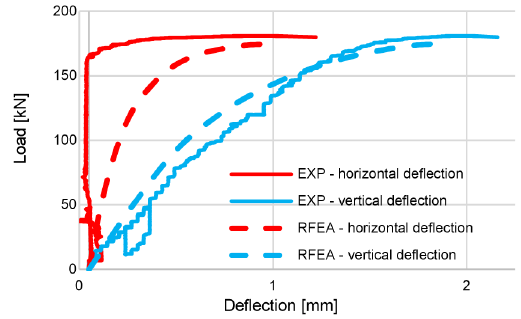
Fig. 13. Load-deflection curve for specimen D